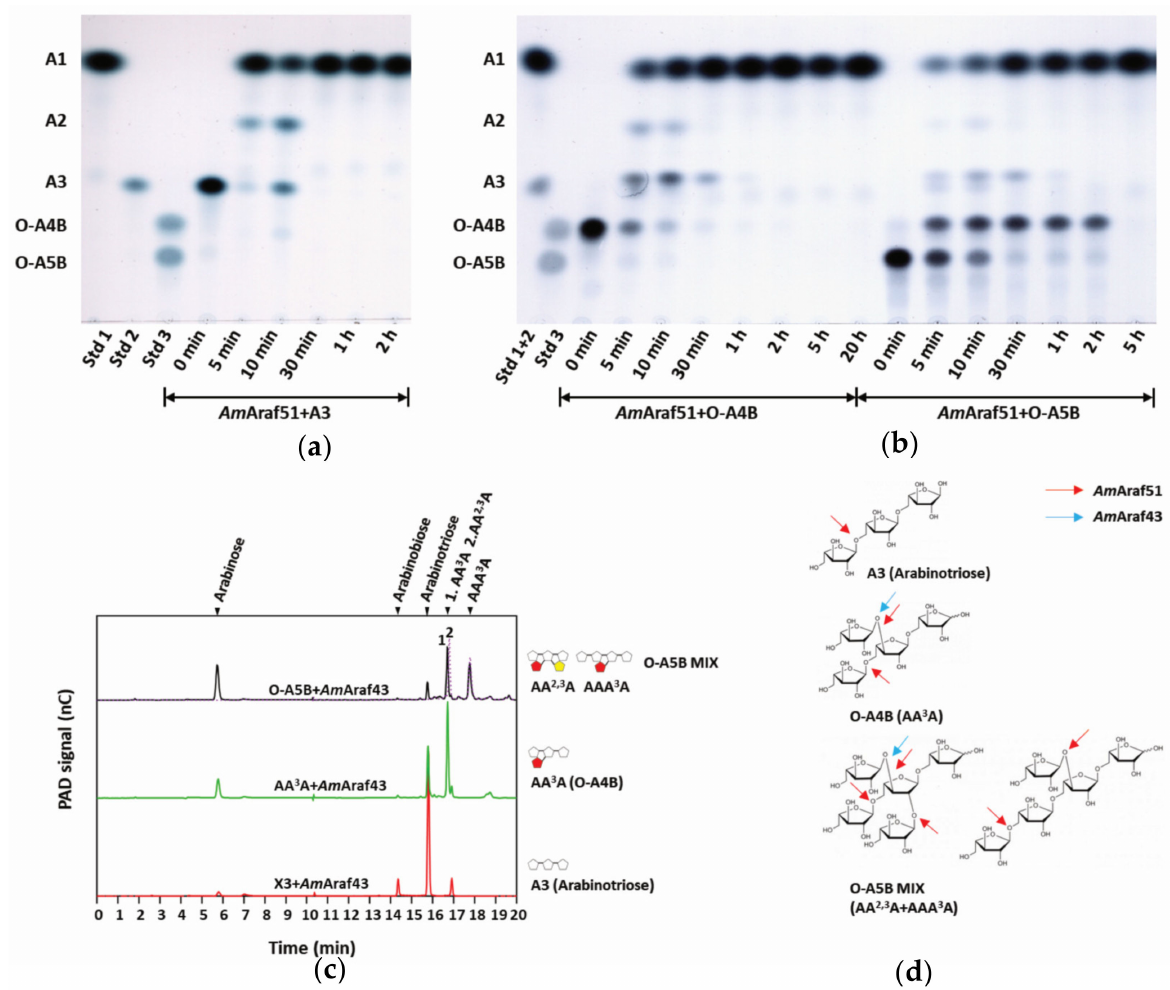
Figure 5. Time-course analysis of hydrolysis products of Am Araf51 with AOS by TLC ( a ) arabinotriose and ( b ) O-A4B or O-A5B as substrates. ( c ) HPLC analysis of hydrolysis products of Am Araf43 with AOS for 22 h of incubation (AA 3 A and AA 2,3 A are quite close, AA 3 A matches the left of the two peaks at a retention time of around 17 min). ( d ) Structure of three different AOS. Standard reaction was performed by incubating 85 nM Am Araf51 and 82 nM Am Araf43 with different AOXs at pH 6.0 and 60 ◦ C for Am Araf51 and at pH 5.0 and 40 ◦ C for Am Araf43 at different time periods. 2.5 µ L of